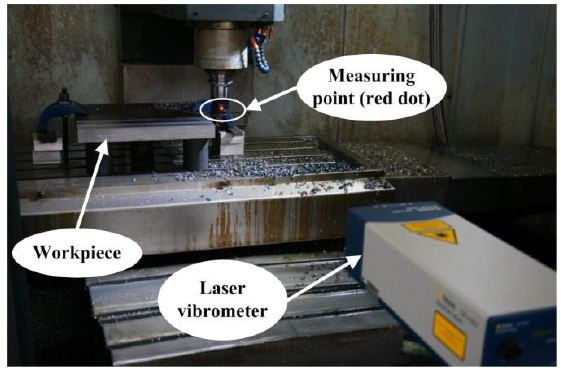
Figure 2. Experiment design.